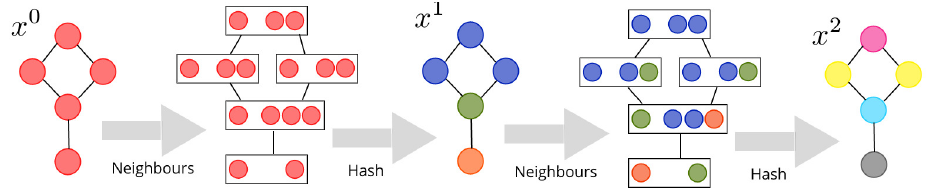
Figure 1. Two iterations of the Weisfeiler–Lehman ( WL ) algorithm, starting with uniform